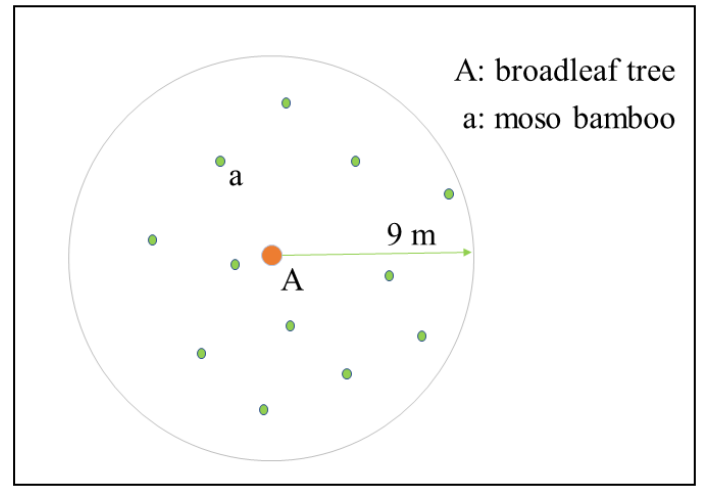
Figure 2. Schematic diagram of stands. Table 1. Stand characteristics of bamboo – broadleaf mixed forests.